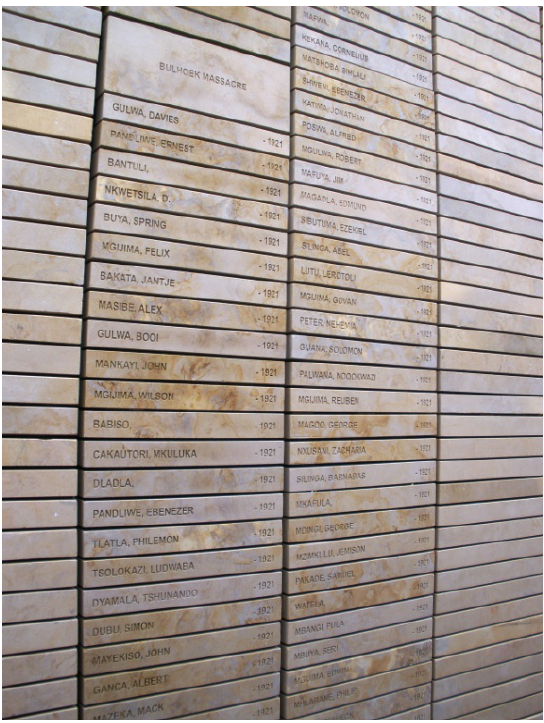
Figure 20. Detail of the Wall of Names, Freedom Park, Pretoria (author’s